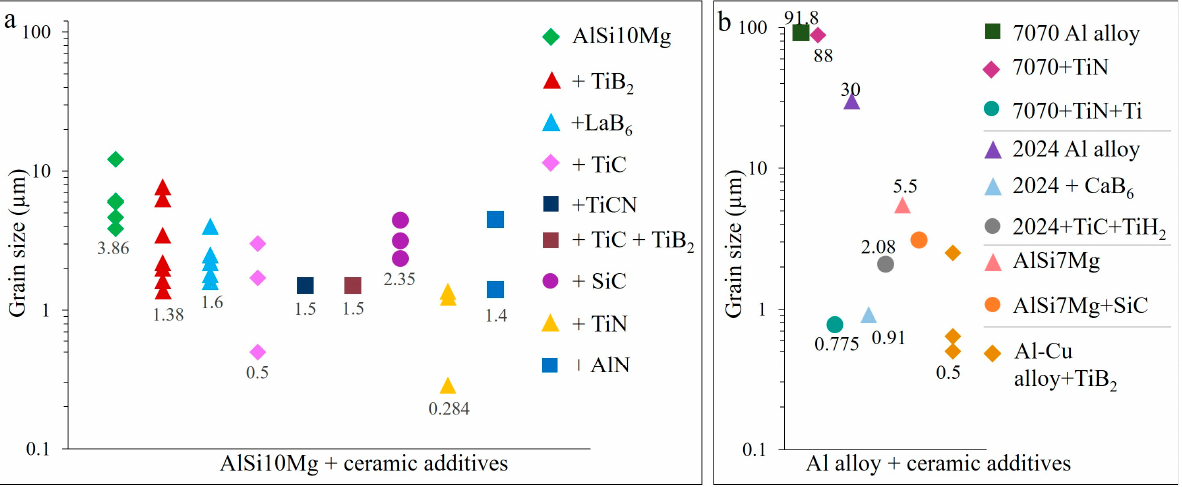
Table 4. The effect of reinforcing compounds on the fabrication and properties of AMCs and their optimal content limit.